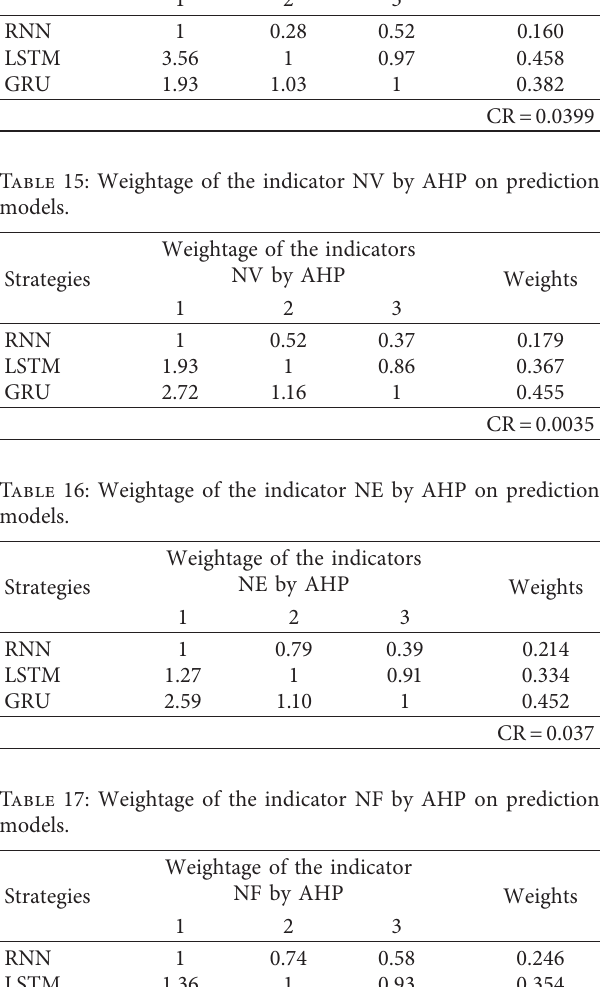
Table 14: Weightage of the indicator NL by AHP on prediction models. Weightage of the indicators Strategies